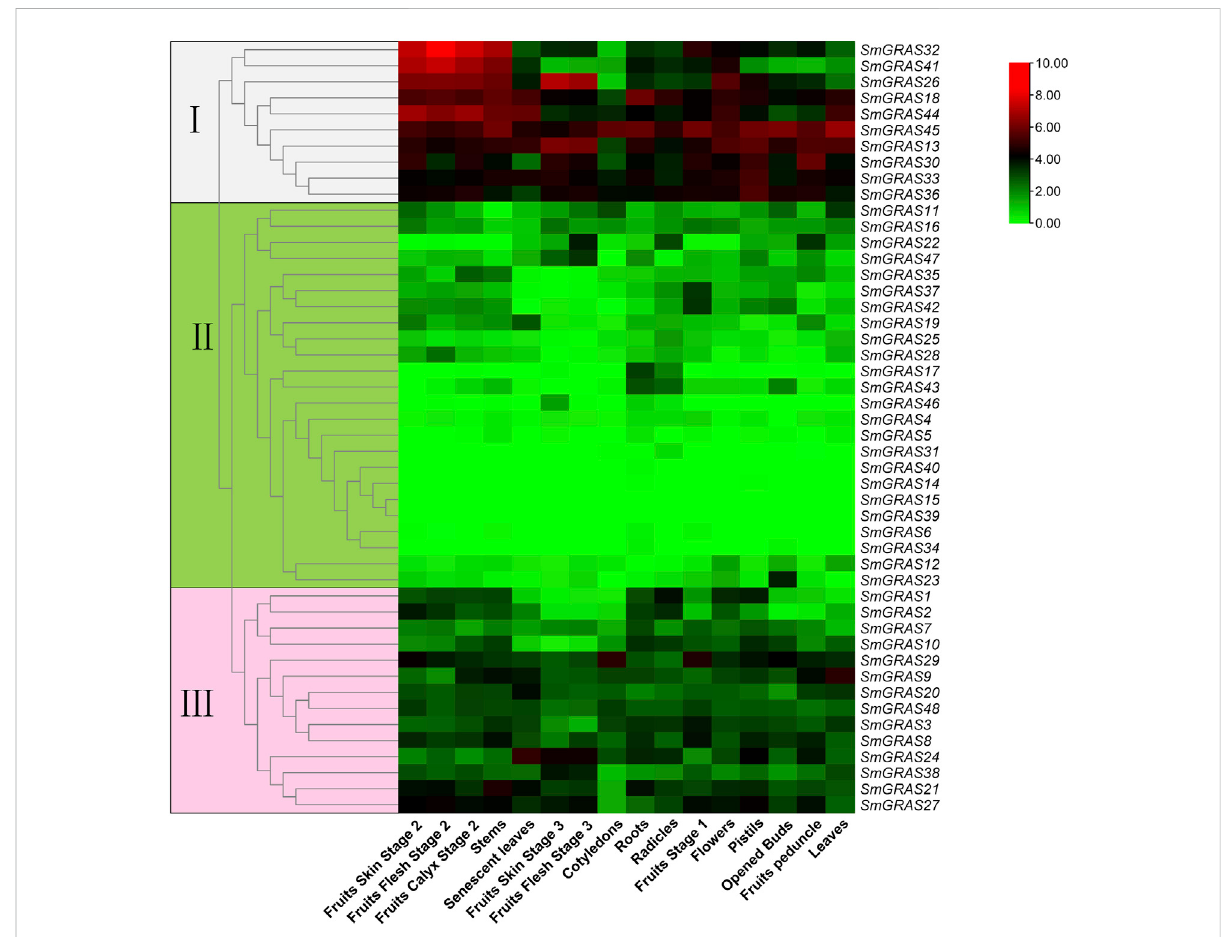
FIGURE 6 Expression analysis of Sm GRAS s in different tissues and different stages. The three colored boxes on the left of the picture symbol indicate the subfamily that the corresponding gene on the right belongs to.